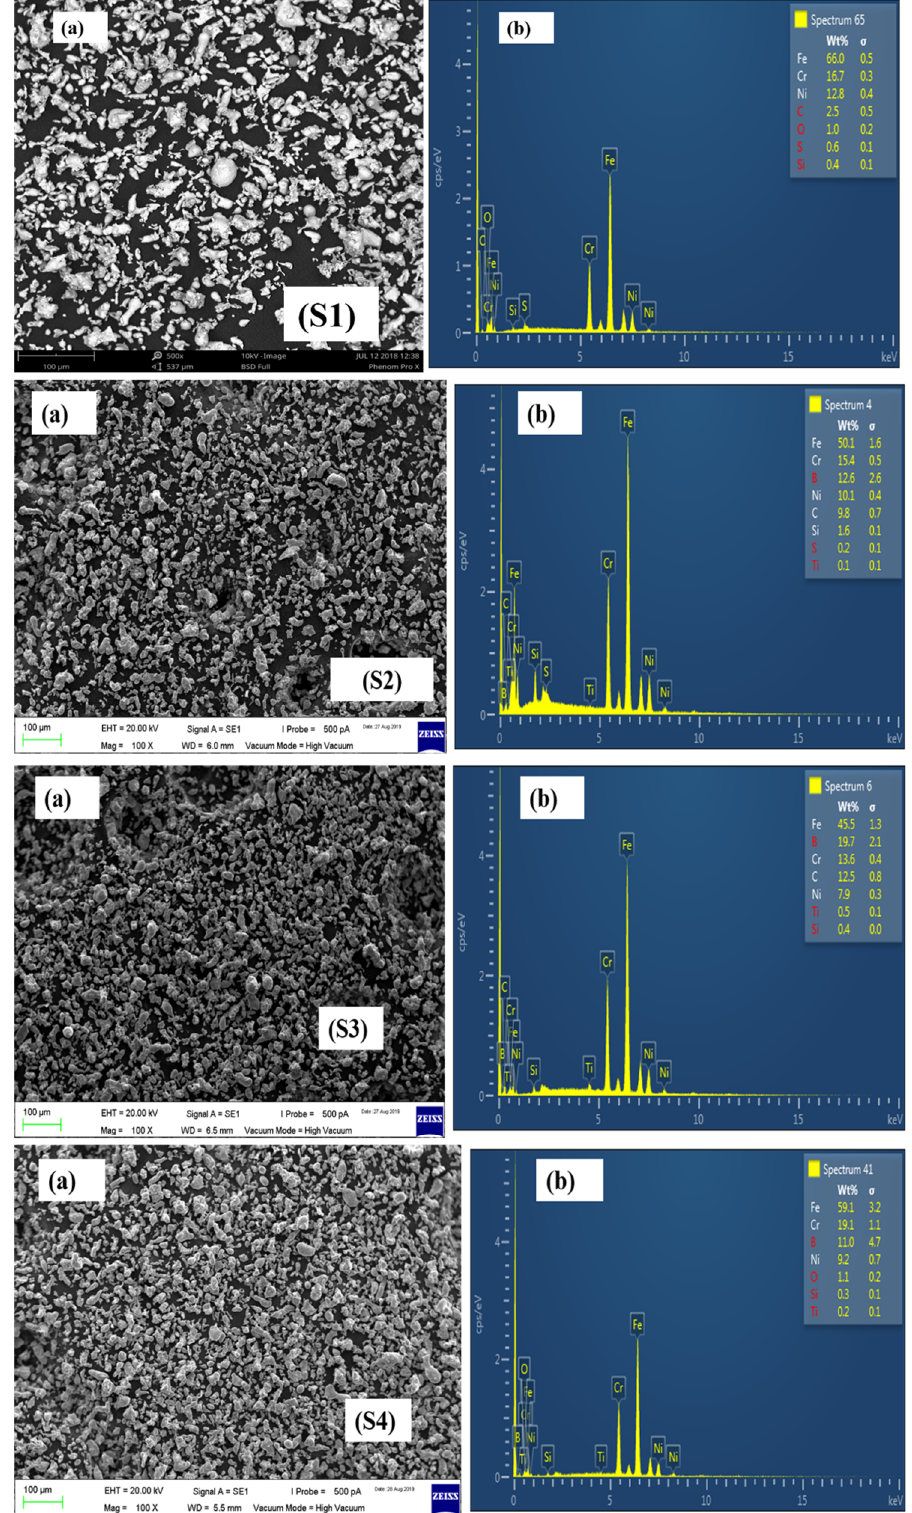
Figure 5. SEM images of S1, S2, S3, and S4 powder formulations. The SEM analysis revealed uniform dispersion of the powders. The presence of boron and titanium particles was confirmed from the EDX results. The respective concentrations of each constituent at a particular spectrum were given by EDX and reported for all the powder formulations.